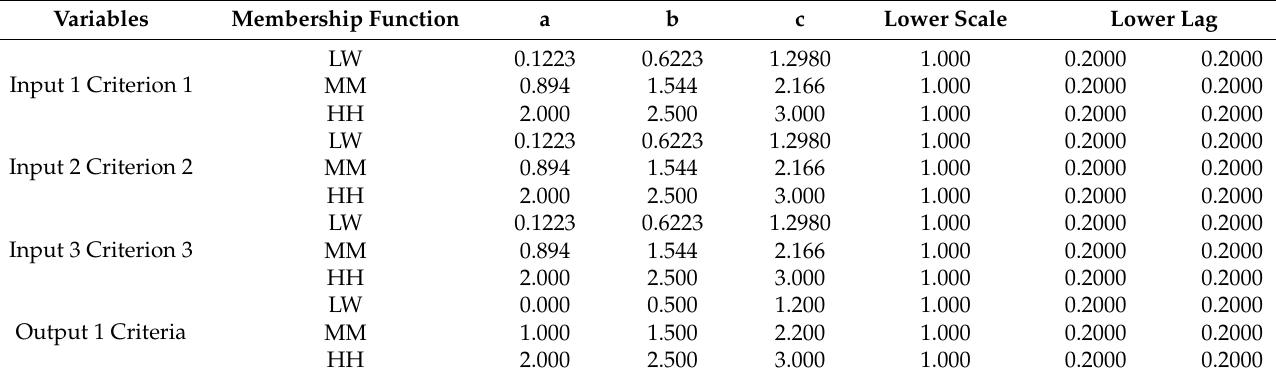
Table 16. Fist Type-2 FIS: Input-Output parameters.